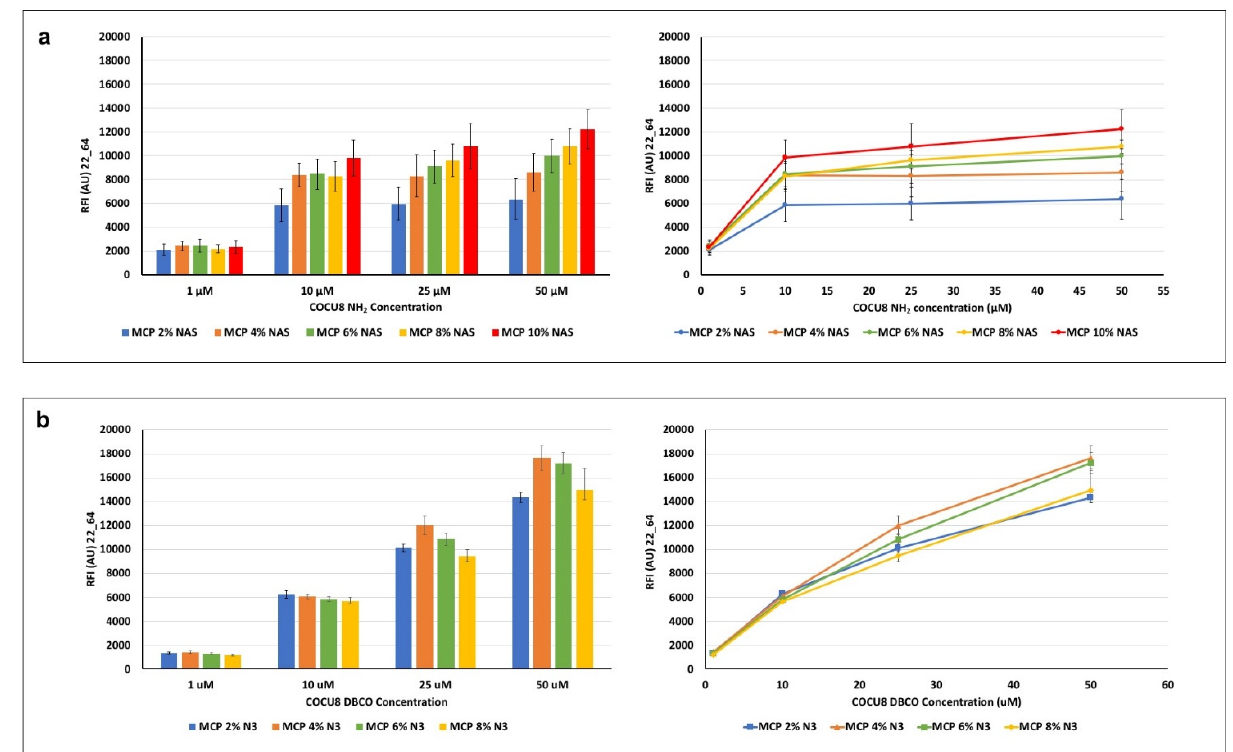
Figure 5. Fluorescence intensity signals obtained after hybridization of an immobilized oligonu- cleotide with its Cy-3 labelled complementary strand. The ( a ) amino-modified or ( b ) DBCO-modified oligonucleotide probe was immobilized at increasing concentrations (1, 10, 25, 50 µ M) on surfaces coated with MCP polymers bearing increasing concentrations of ( a ) NAS, a monomer able to co- valently bind amine probes; or ( b ) azide groups which react with triple bonds. Fluorescence was measured with a confocal laser scanner with power set at 22% and the photomultiplier tube gain (PMT) at 64%. The reported signal intensities are the average of the Relative Fluorescence Intensity (RFI) of each 10 × 2 subarray, each corresponding to a single oligonucleotide concentration. Therefore, the error bars are the standard deviations of the fluorescence intensity of 20